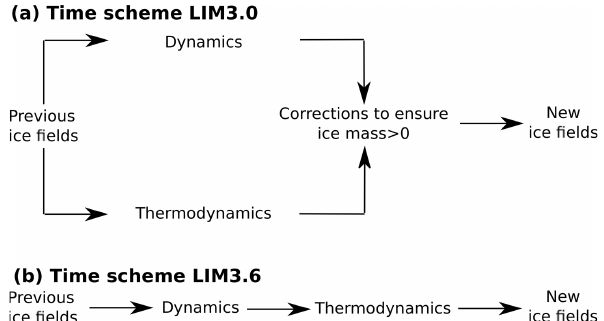
Figure 1. Illustration of the changes in the time scheme. (a) The original time scheme used in LIM3.0 treats ice dynamics and ther- modynamics in parallel, requiring a correction step to ensure that the ice mass is strictly positive. (b) The new scheme of version 3.6 uses an operator splitting approach, so that dynamics is calculated before thermodynamics, and therefore no correction is